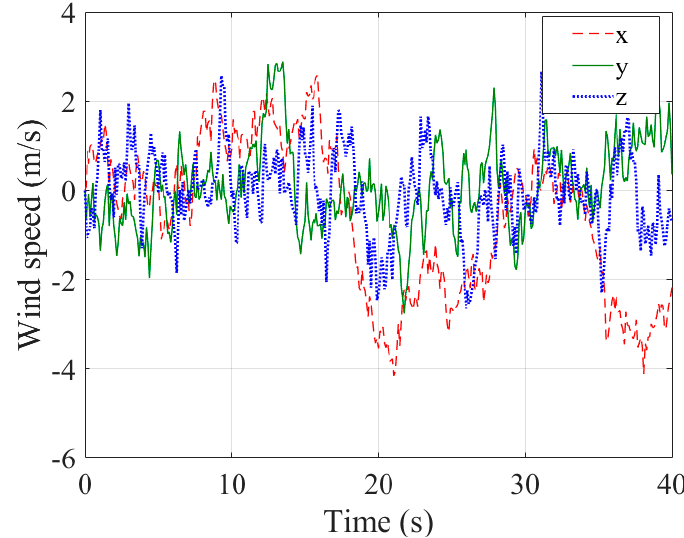
Figure 10. Random wind speed generated by Dryden model.